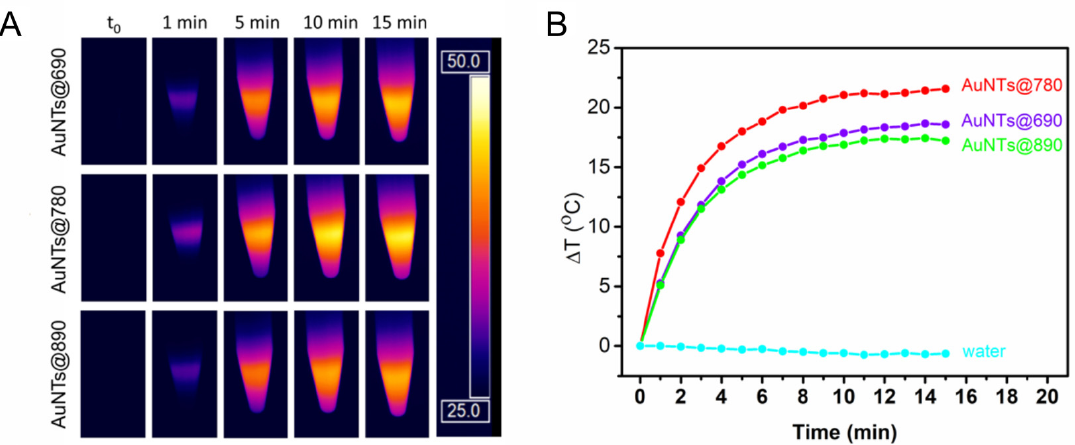
Figure 2. ( A ) The thermographic images of AuNTs during the irradiation with a 785 nm laser for 15 min and ( B ) The extracted corresponding thermal curves.